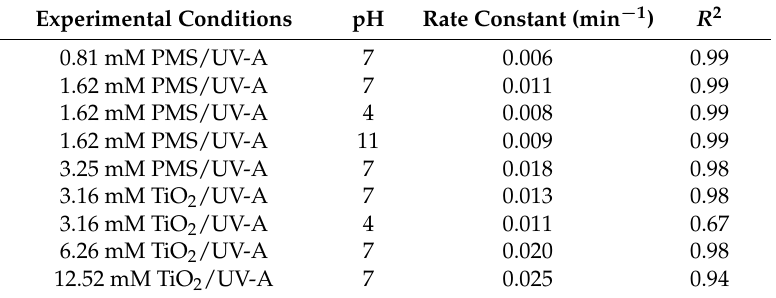
Table 1. Pseudo-first-order kinetic rates (min − 1 ) for the photolytic activation of PMS and TiO 2